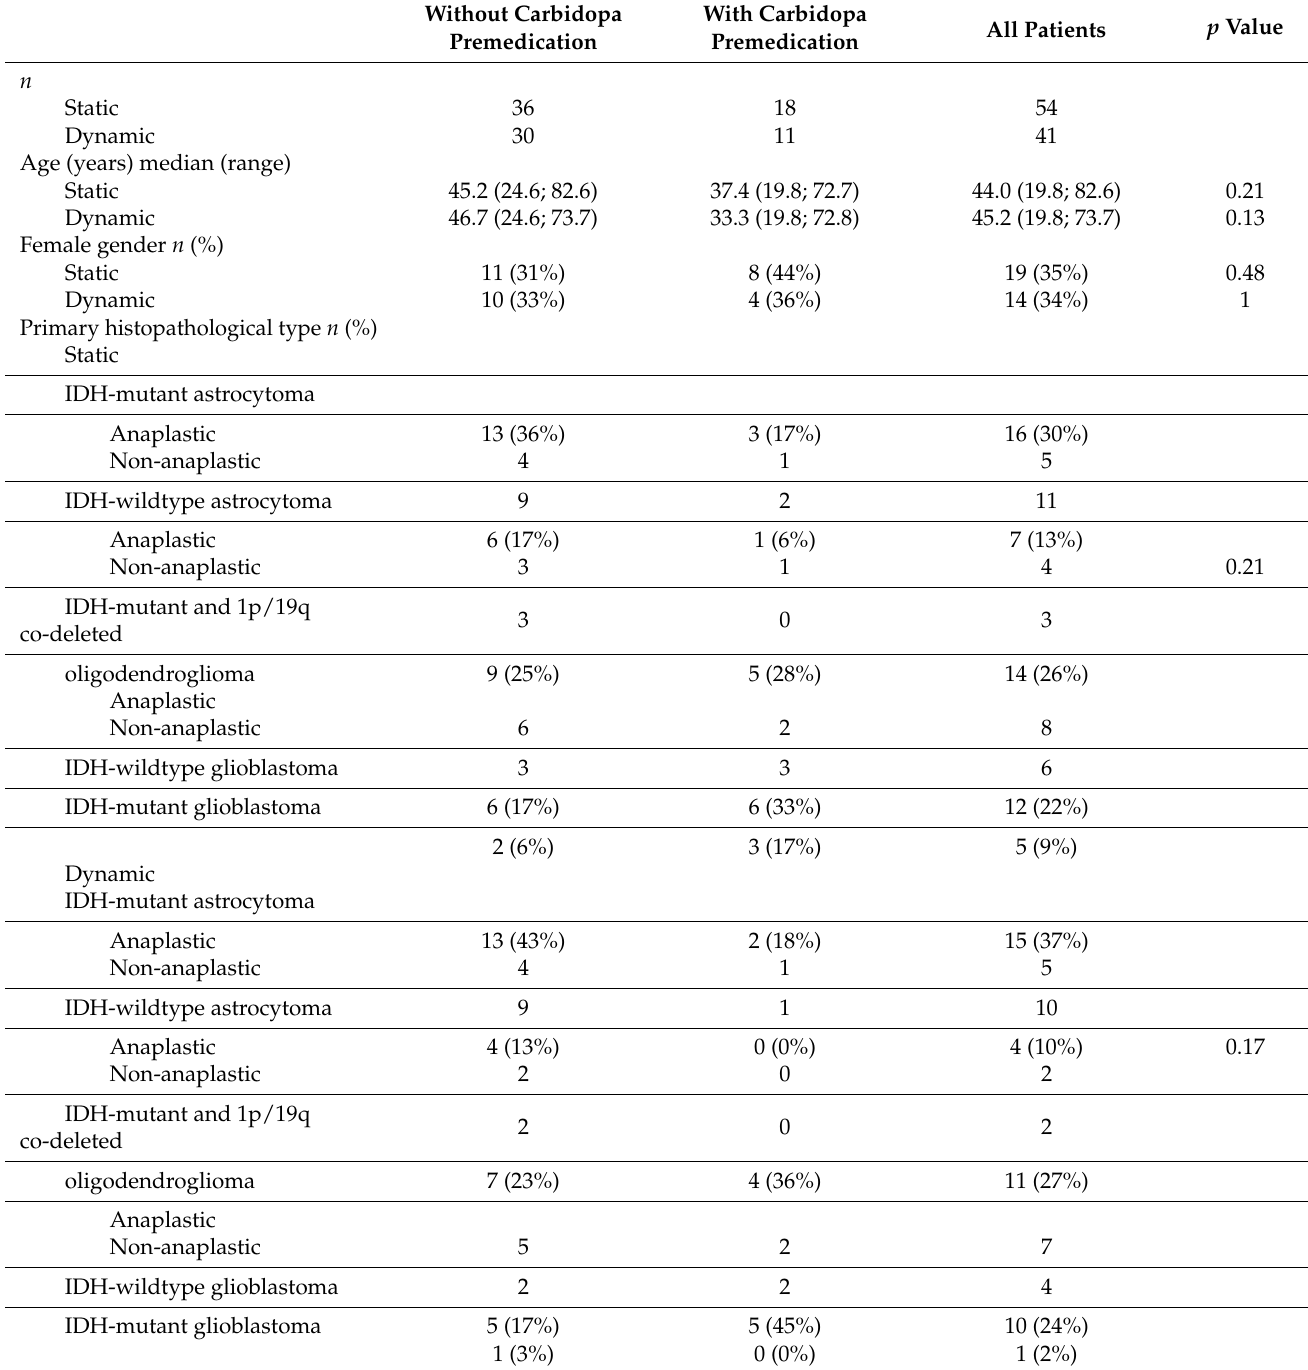
Table 1. Patient